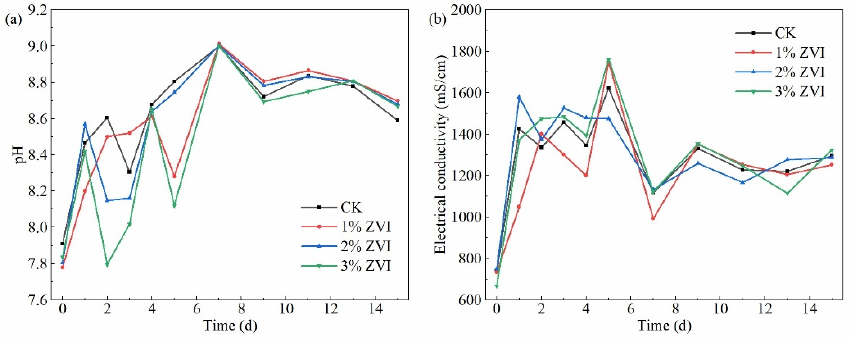
Figure 7. Change in pH ( a ) and electrical conductivity ( b ) under different ZVI additions. ZVI: zero-valent iron.